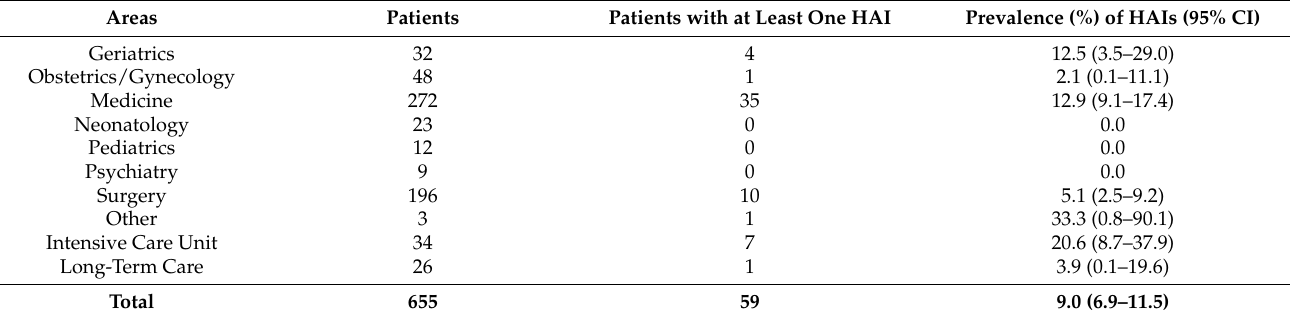
Table 1. Prevalence of healthcare-associated infections by ward